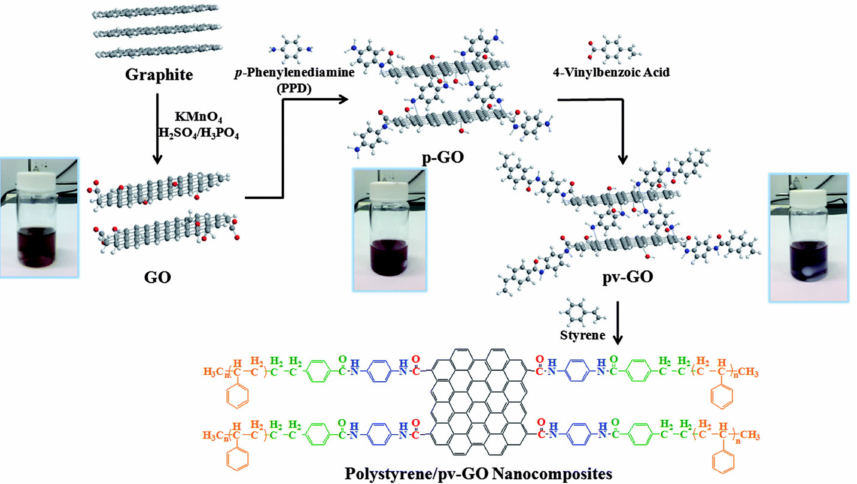
Figure 14. Synthesis of organo-functionalized graphene oxide [119]. Reproduced with permission from ref. [119]. Copyright 2014 Royal Society of